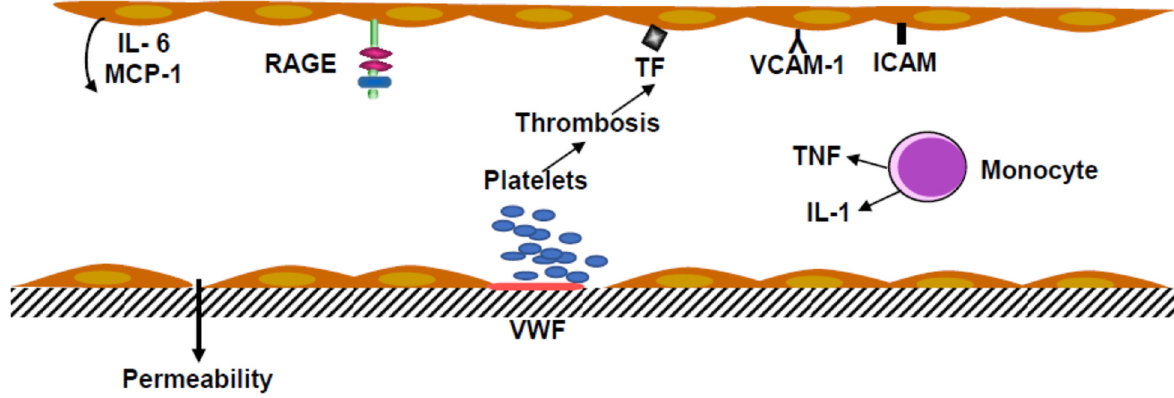
Figure 2. Inflammation and thrombosis in the vascular endothelium. Platelets adhering to the subendothelium, including von Willebrand factor (VWF) recruiting circulating platelets to form an aggregate. Leukocyte integrins bind to Vascular Cell Adhesion Molecule-1 (VCAM-1) and Intercellular Adhesion Molecule (ICAM). Activation of the receptor RAGE, a multiligand receptor, induces the release of Macrophage Chemoattractant Protein-1 (MCP-1) and Interleukin-6 (IL-6), and the production of Tissue Factor (TF). Monocytes stimulated by bacteria, endotoxins and viruses release tumor necrosis factor (TNF) and interleukin-1 (IL-1).